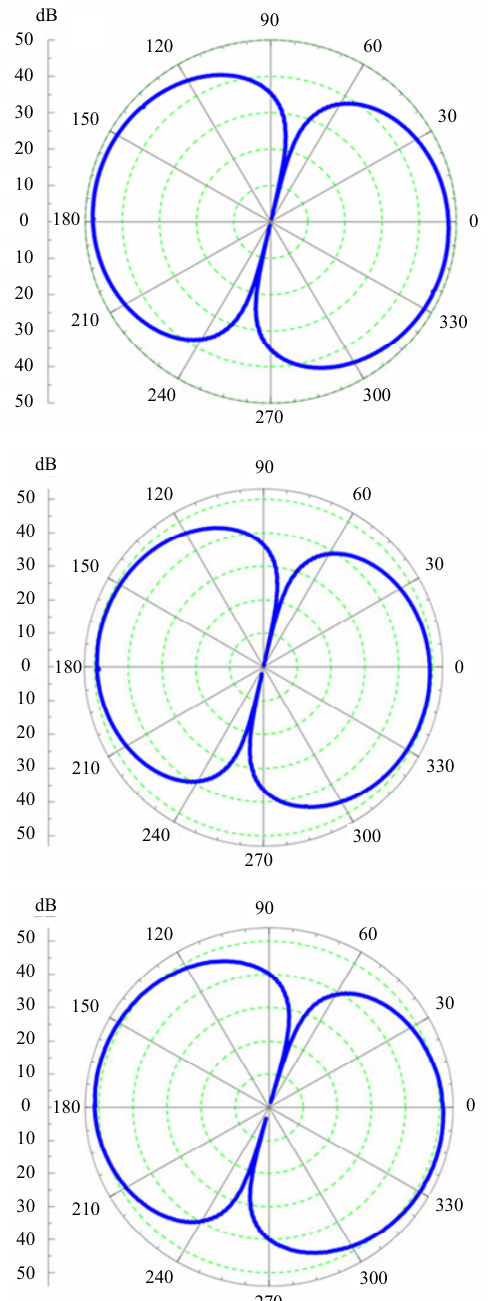
Fig. 9 Three-axis directivity of FOVH at the frequency of 160